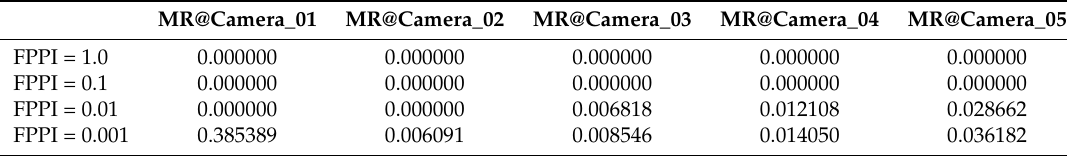
Table 12. Accuracy table @ Cameras_01–05, informed-filters, some viewpoints.